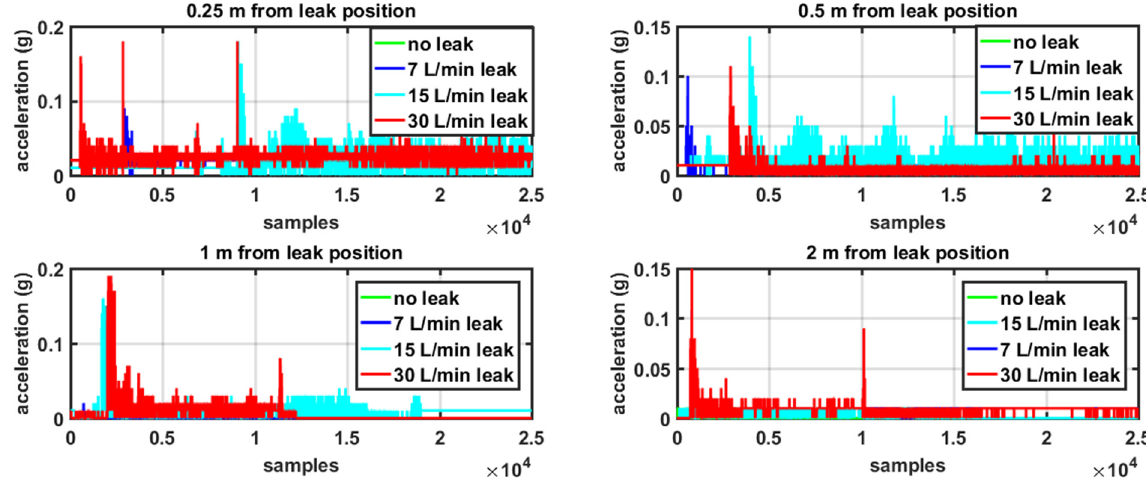
Figure 7. Leak characterization.